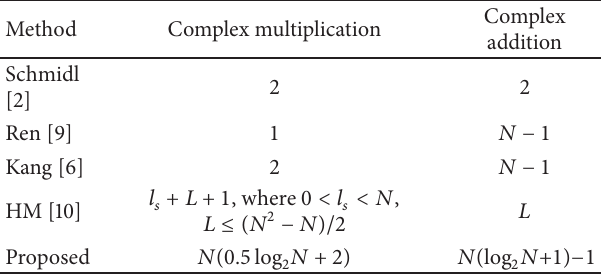
Table 1: Computational complexity of different